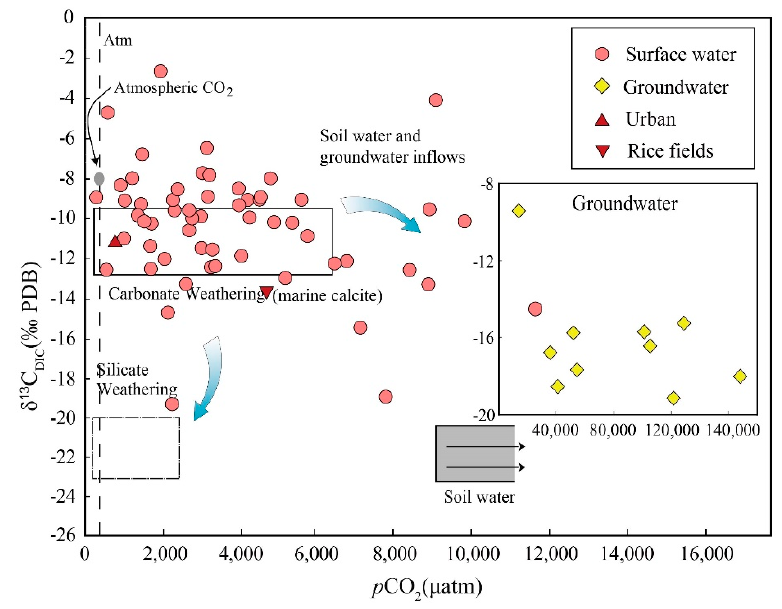
Figure 4. Variation between δ 13 C DIC values and p CO 2 . Figure based on (elmer and Veizer [17], Cartwright [20]).